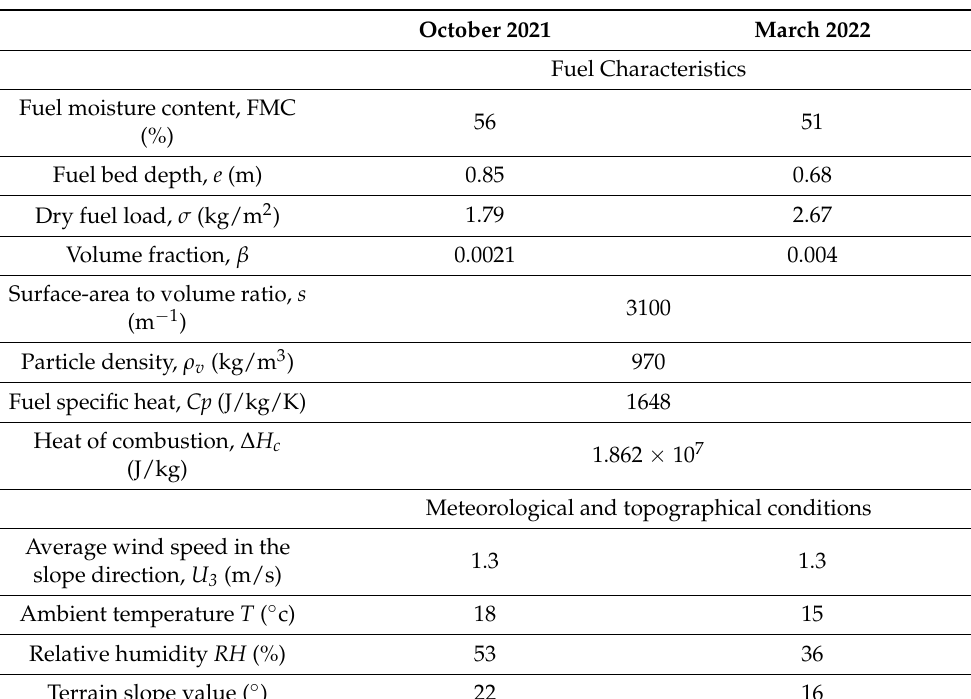
Table 1. Main average properties of Genista salzmannii vegetation and meteorological and topograph- ical